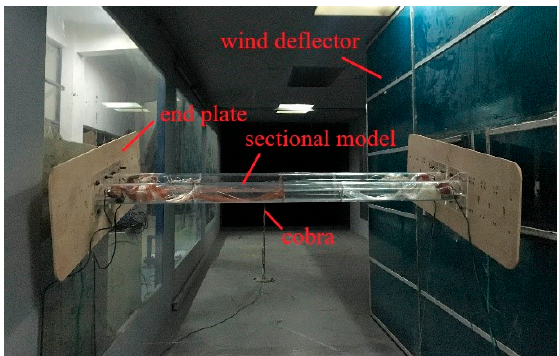
Figure 3. Layout of section model and apparatus in the wind tunnel.